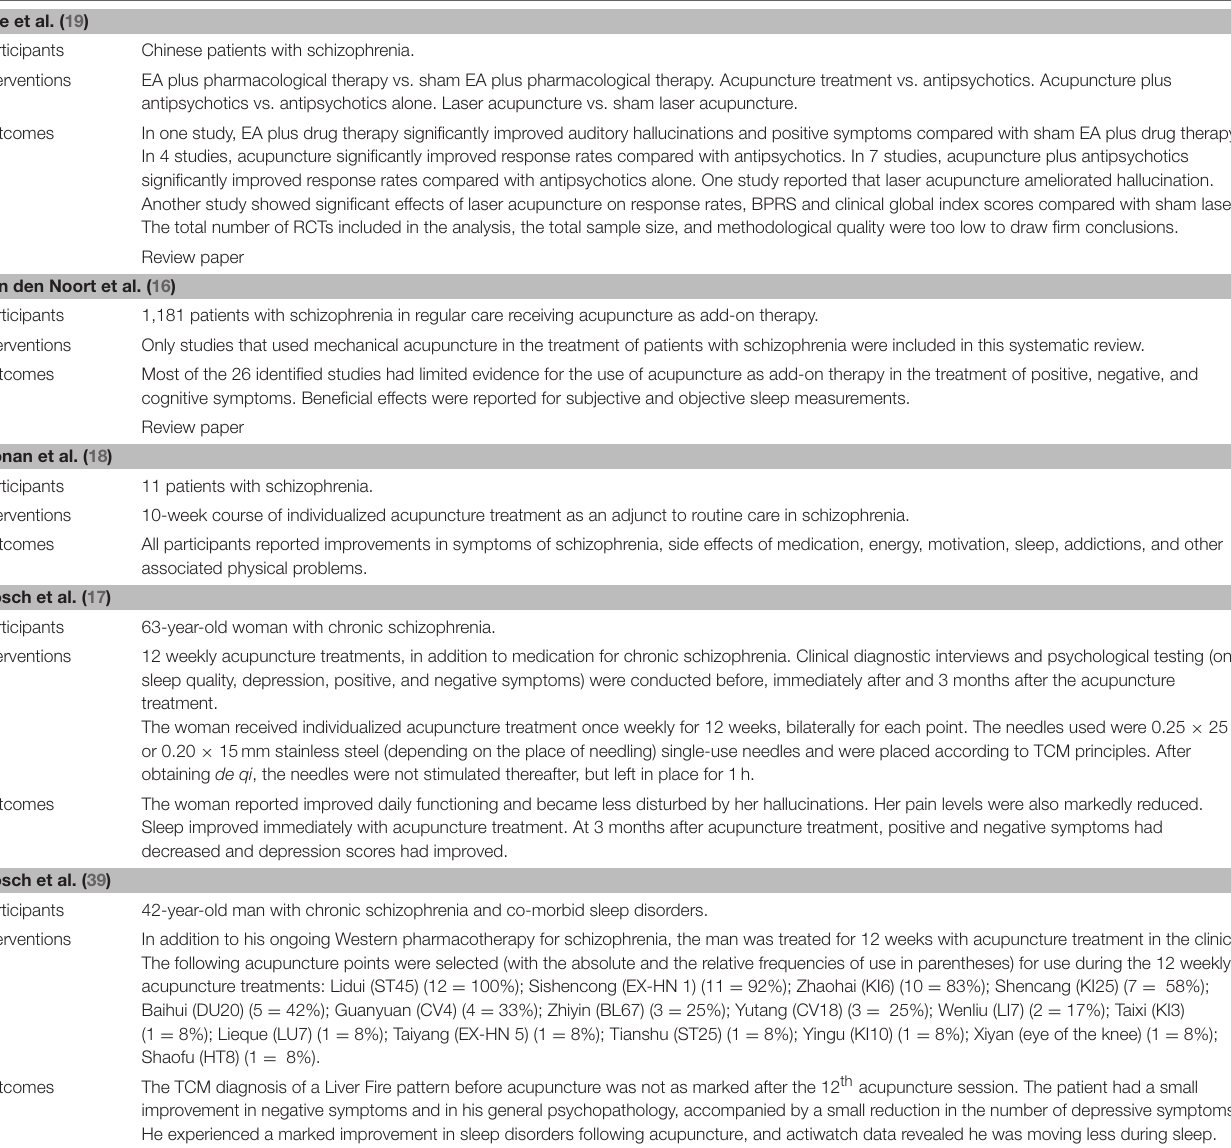
TABLE 2 | Overview of characteristics of included studies evaluating acupuncture for